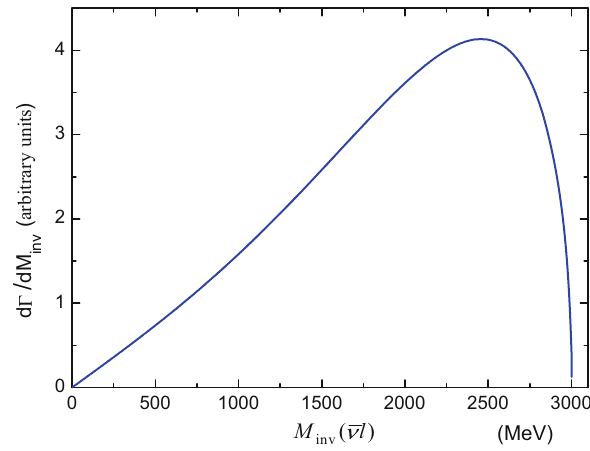
Fig. 5 The invariant mass distribution for ¯ ν l l in the (cid:2) b → ¯ ν (cid:2) ( 2790 ) . The one for the (cid:2) l l c